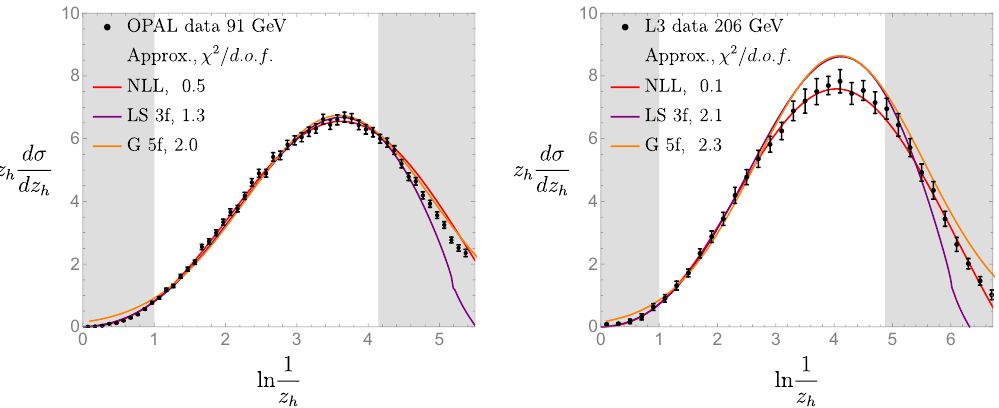
Figure 5 . The fragmentation spectrum for e + e − → h ± + X at center of mass energies Q = 91 and 206 GeV. The gray region is excluded from the χ 2 / d.o.f. determination based on hadron mass corrections or z (1) , and the quoted χ 2 / d.o.f. is the goodness-of-fit for that data set. Compared h ∼ O to the NLL curve is the evolved 3 flavor scheme MLLA limiting spectrum (purple LS) from ref. [8], and a 5 flavor scheme evolving the moments of a Gaussian according to the MLLA anomalous dimension, as in ref. [5] (orange G).